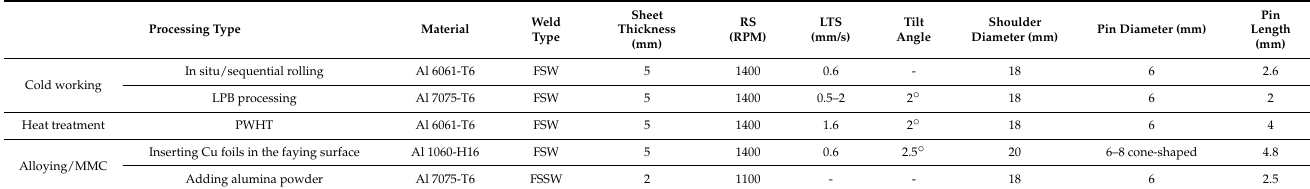
Figure 5. ( a ) The process of creating MMC through adding alumina powder in the weld nugget of FSSW joints; ( b ) a typical FSSW joint sample with the A–A cross-sectional view. The details on the process parameters and friction welding operations, including the rotational speed (RS), linear transverse speed (LTS), tool tilt angle, pin and shoulder diameters/lengths for conducted tests on aluminum joints, are tabulated in Table 1. Table 1. Process parameters for friction stir welding operations on aluminum joint samples.